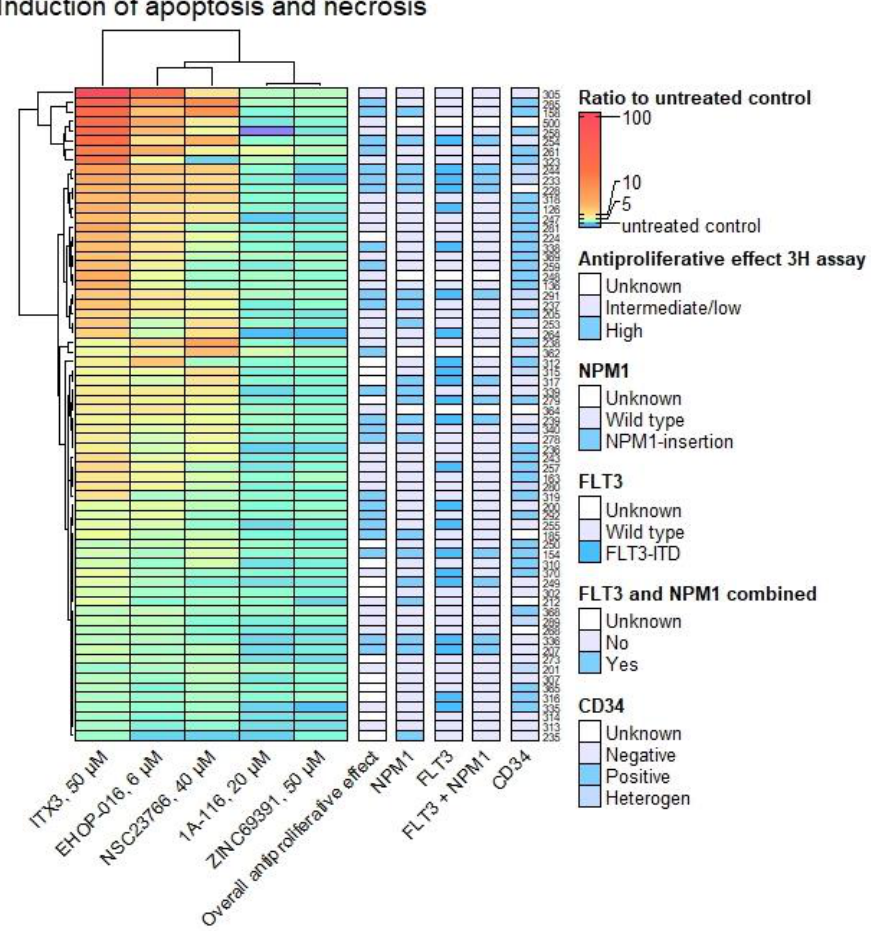
Figure 5. Rac1 inhibition induced apoptosis and necrosis in AML cells. Heatmap of apoptosis and necrosis combined by the Annexin V/PI apoptosis assay after 48 h of culture, as a ratio to the untreated control set to 1. Blue and purple colors indicate a lower ratio of apoptosis and necrosis than the control. Green indicates a slightly higher ratio than the control; yellow, orange, and red colors, even greater. Each row is a patient sample; each column is a Rac1-inhibitor, with the highest concentration tested. The columns on the right side of the heatmap indicate NPM1 and FLT3 mutational status and CD34 expression for each patient sample. The column “Overall antiproliferative effect” indicates whether the sample had an overall high or an intermediate or low antiproliferative effect of the compounds by the 3 H-Thymidine proliferation assay. A Fisher’s exact test was applied by dividing the compounds’ overall heatmap, and separate heatmaps for each compound (not shown), into two groups that were analyzed with the available characteristics. More profound apoptosis and necrosis were common in CD34-negative samples only for ITX3 ( p = 0.024). No other significant results were found when looking for associations with a high degree of apoptosis and